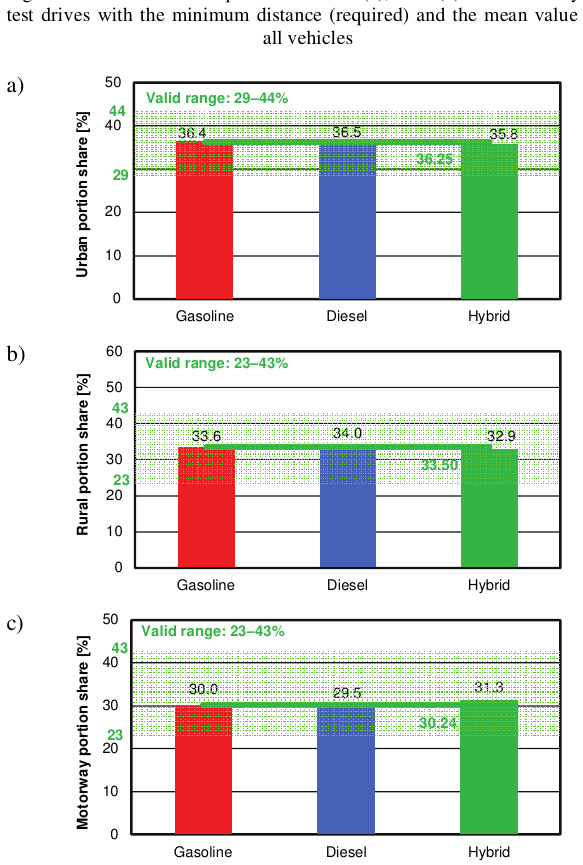
Fig. 7. Test time share comparison of urban (a), rural (b) and motorway (c) test drives with the minimum distance (required) and the mean value for all vehicles